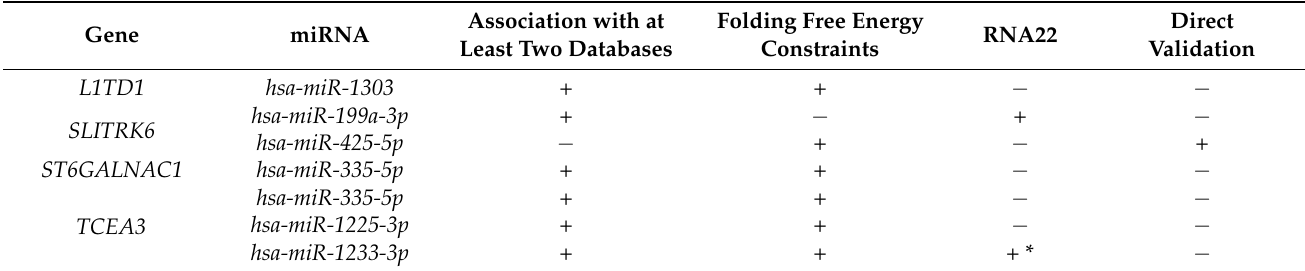
Table 3. Condensed view of prioritization results for the miRNAs identified for further validation. Gene